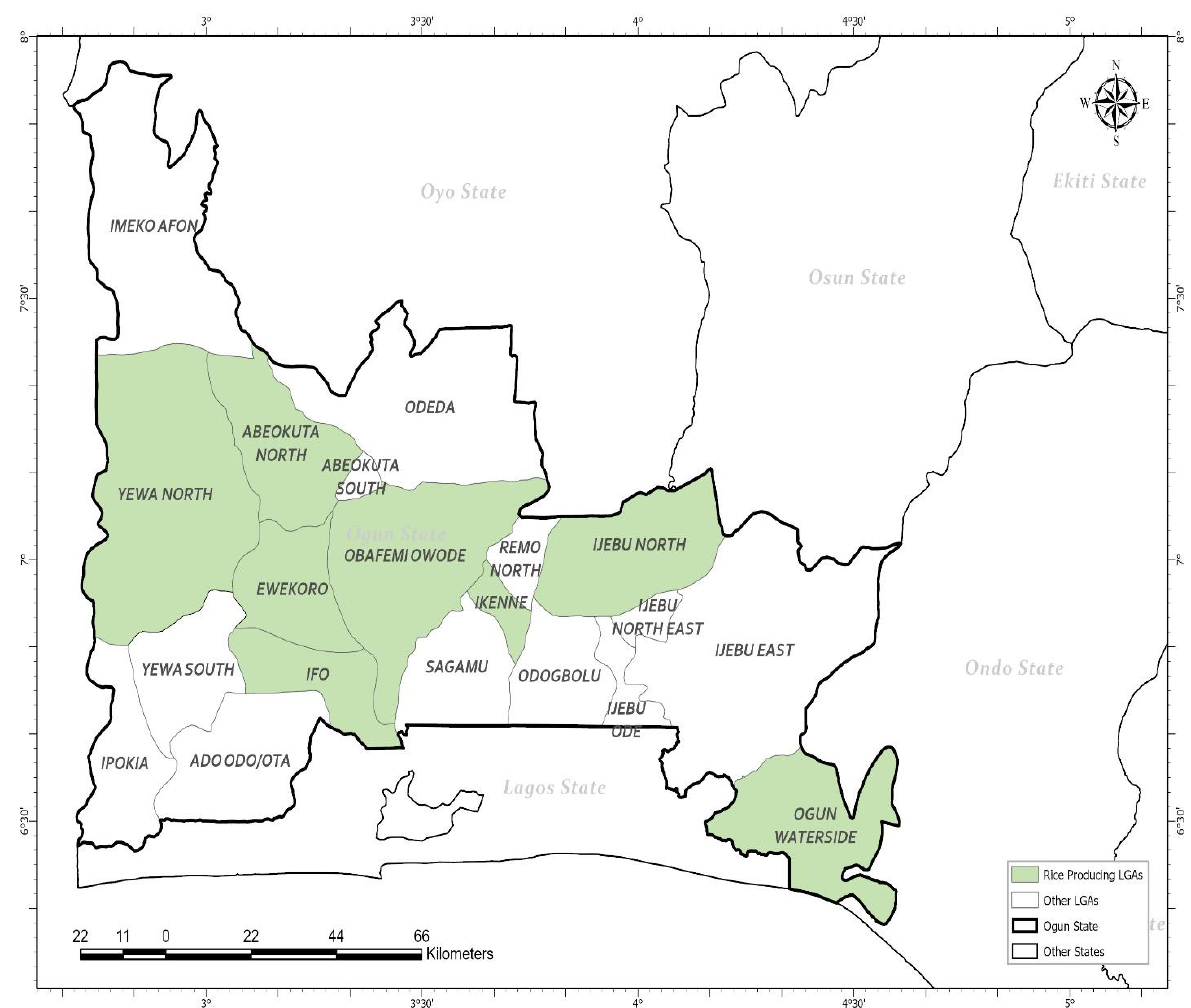
Figure 1. The map showing rice producing local government areas in Ogun State. For data collection, a multistage sampling technique was employed. In the first stage, four Local government areas (LGAs) were selected based on their agricultural